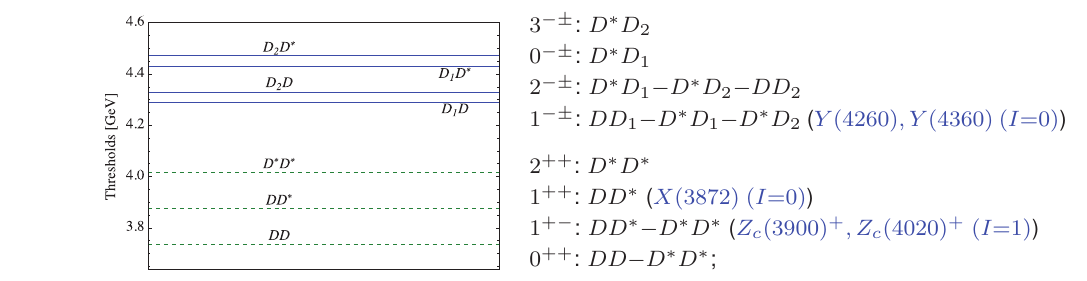
Figure 1. Illustration of the location of the lowest S -wave thresholds of narrow ope–flavor states together with a list of candidates of associated hadronic